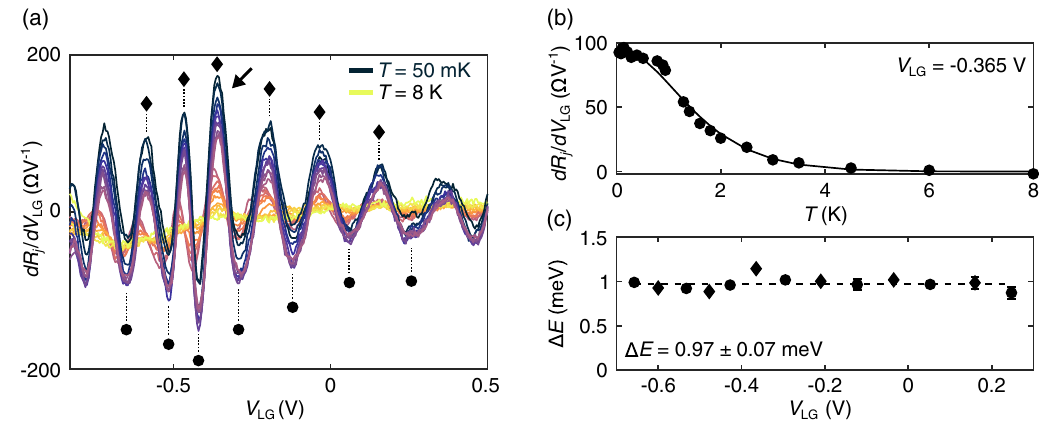
− 1 . 8 V and in a FIG. 2. (a) Temperature dependence of the resistance oscillations in dR j =dV in the pn 0 p configuration at V LG TG ¼ reduced range in V , chosen so as to highlight the oscillation behavior upon changing the temperature from 50 mK to 8 K. Dotted lines LG and symbols mark local minima (circles) and maxima (diamonds) used in the analysis presented in (c). (b) Fit of the temperature − 0 . 365 V, indicated by the arrow in (a), with a thermal damping function, Eq. (1). dependence of the local maximum at V LG ¼ (c) Summary of the mode spacing Δ E in the cavity extracted from the local minima and maxima marked in (a). The mean and standard deviation obtained when factoring in all points is inset. The individual points have relative errors of around 5%, such that the error bars are as large as or smaller than the point